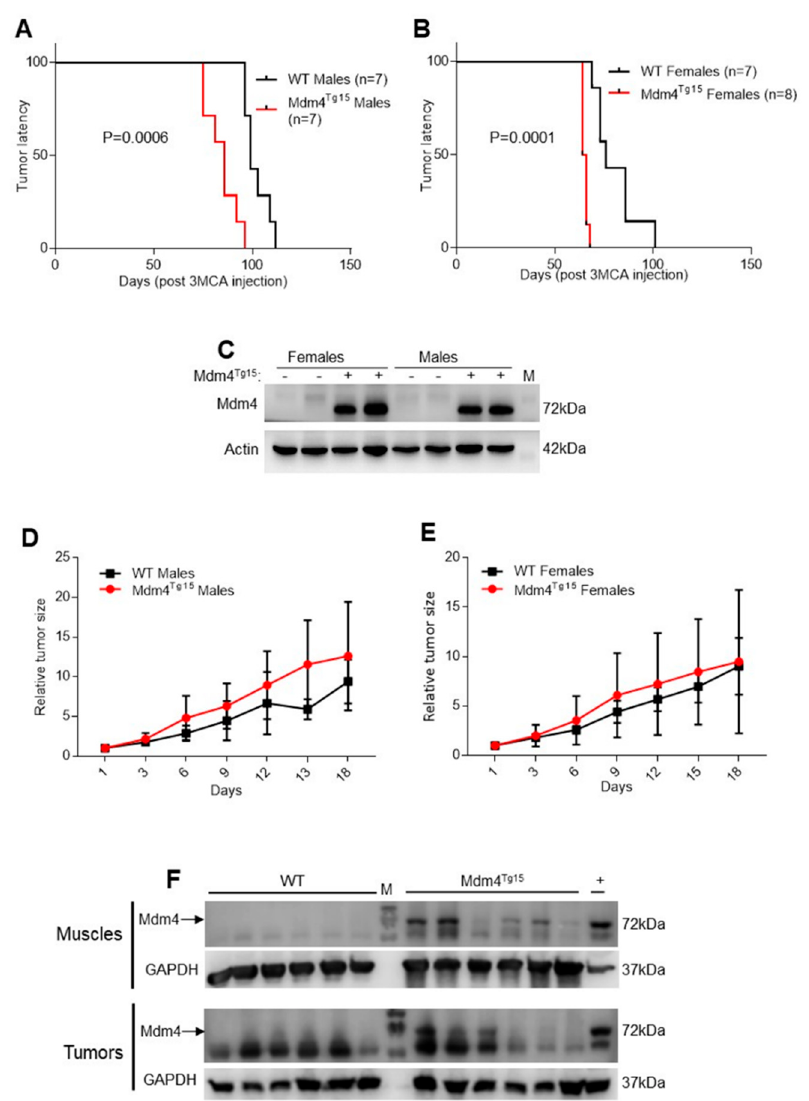
Figure 1. Mdm4 accelerates DNA-damage induced tumorigenesis. ( A , B ) Tumor latency in wildtype (WT) and transgenic Mdm4 Tg15 males ( A ) and females ( B ). Fibrosarcomas were induced by a single injection of 3-MCA in the hindlimb muscle of age-matched animals (Log-rank test ( A ) df = 1, χ 2 = 11.87; ( B ) df = 1, χ 2 = 14.45). The data are representative of 3 ( A ) and 2 ( B ) independent experiments. ( C ) Western blot (WB) analysis of hindlimb muscle from age-matched WT and Mdm4 Tg15 males and females. ( D , E ) Growth curve of fibrosarcoma in WT and Mdm4 Tg15 males ( D ) and females ( E ). Tumor size is relative to the size at the starting point (two-way ANOVA, ( D ) DF = 6, F (interaction) = 1.162, p = 0.338; ( E ) DF = 6, F (interaction) = 0.083, p = 0.9975). ( F ) WB analysis of Mdm4 levels in tumors and matched muscles derived from animals reported in panel ( A ). GAPDH was used as a loading control (LC). M indicates molecular weight.